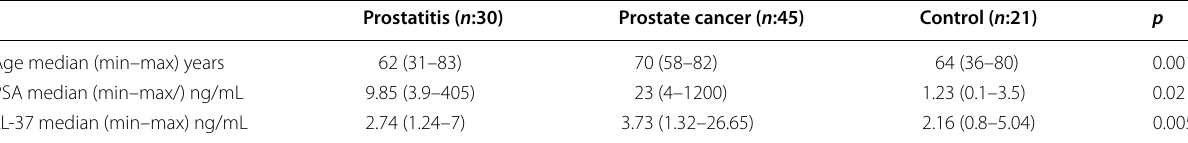
n number of individuals. Kruskal–Wallis test was used for statistical analysis =